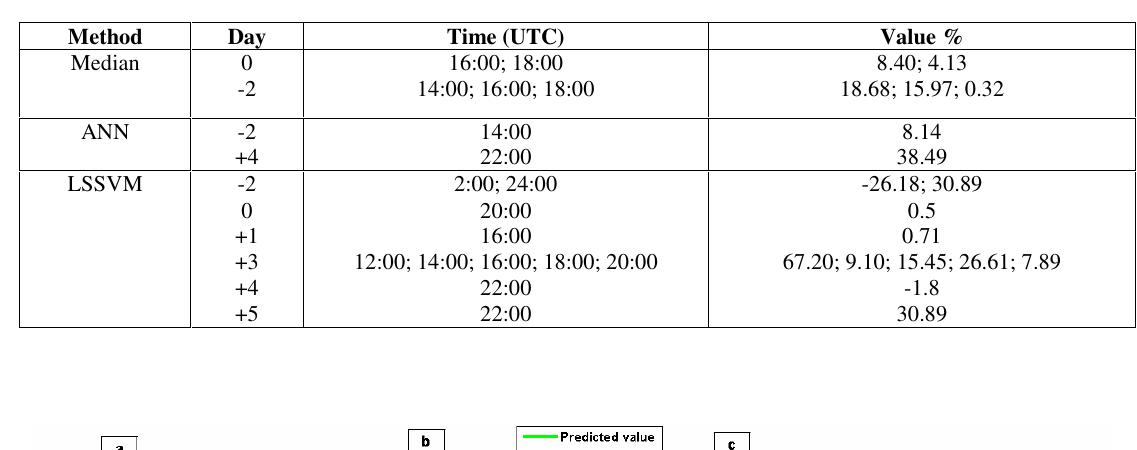
Table 2. The main detected anomalies for Nepal earthquake using the implemented methods. Value is calculated ( ) kkDxp /100 −×±= . Day is relative to the earthquake day. by